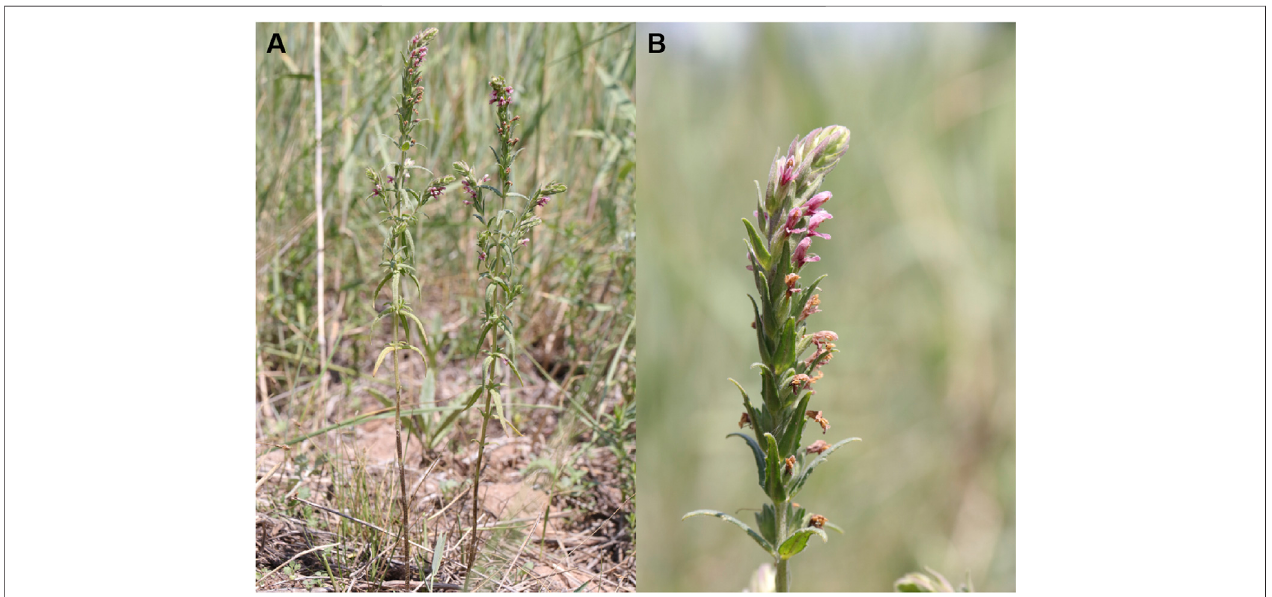
FIGURE 1 | The images of Odontites vulgaris Moench ( A and B